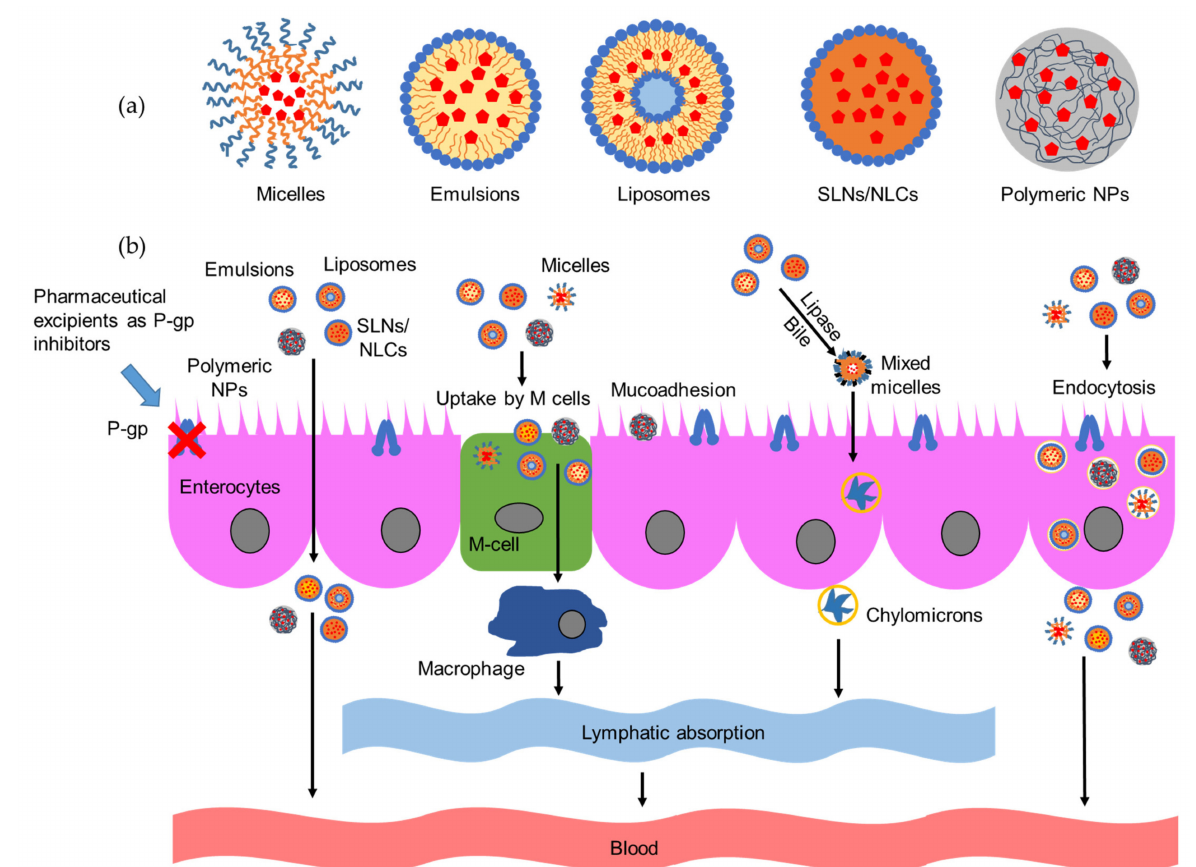
Figure 2. Drug delivery systems can bypass and inhibit P-gp efflux by various effects. ( a ) Typical drug delivery systems to encapsulate P-gp substrate to enhance oral bioavailability. ( b ) Pharmaceutical excipients as components of various drug delivery systems can inhibit P-gp efflux. Different effects of nano drug delivery systems to enhance drug absorption and oral bioavailability. SLNs: solid lipid nanoparticles; NLCs: nanostructured lipid carriers; NPs: